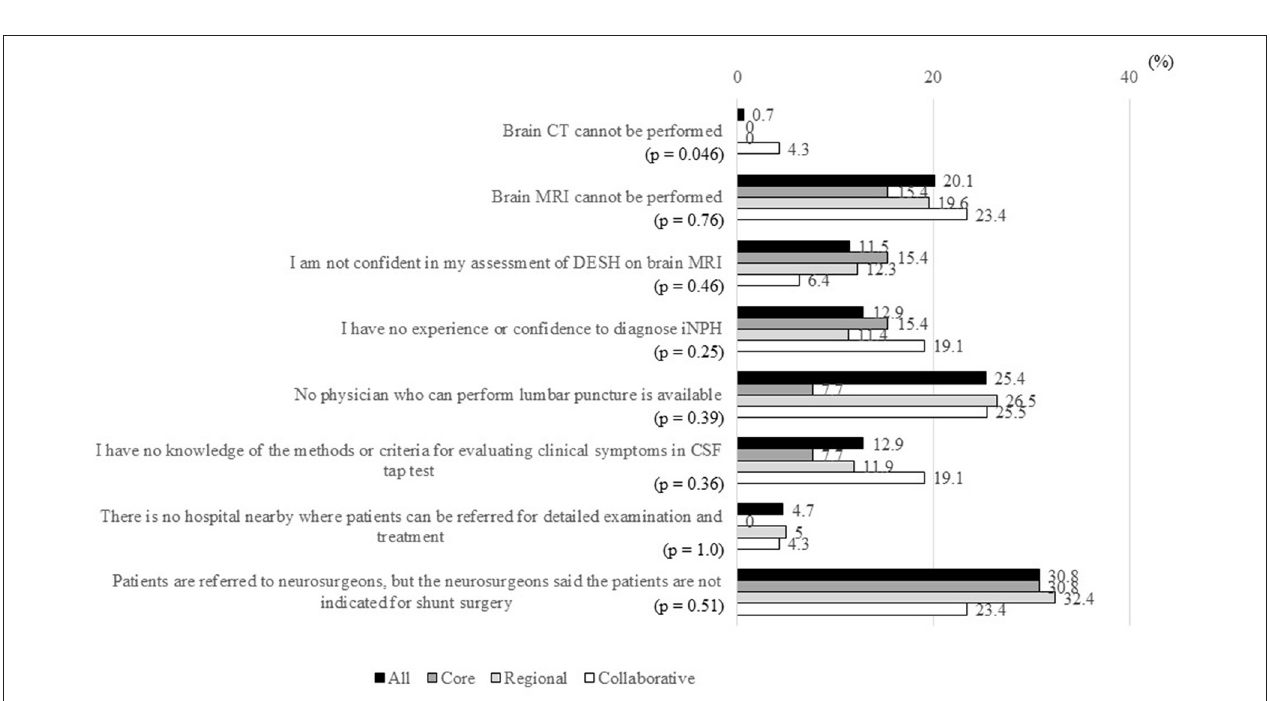
FIGURE 5 | Percentages of MCDs that answered “Yes” to items in response to the question “What are the difficulties in the evaluation and treatment of patients with suspected iNPH?”. MCD, medical center for dementia; CT, computed tomography; MRI, magnetic resonance imaging; CSF, cerebrospinal fluid; DESH, disproportionately enlarged subarachnoid space hydrocephalus; iNPH, idiopathic normal-pressure hydrocephalus; CSF, cerebrospinal fluid. *The ratio of “Yes” answers were compared between the three types of MCDs using Fisher’s exact test.